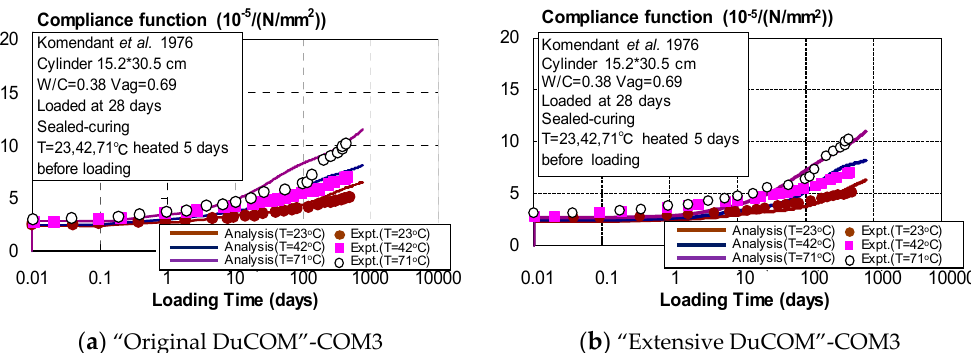
Figure 27. Comparison of basic creep under different temperatures without drying [32].